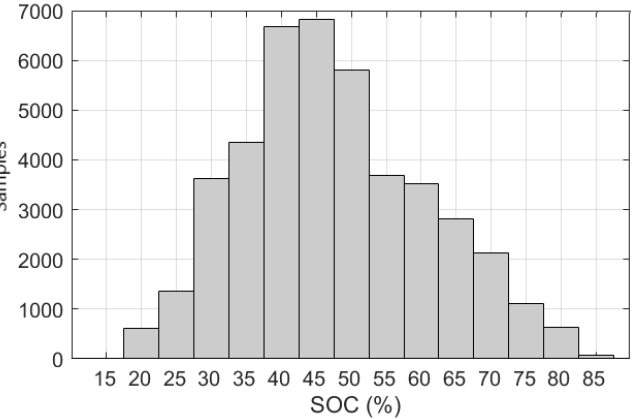
Figure 11. SOC of BESS with 3.1 storage hours for 18 GW scenario of wind power generation in